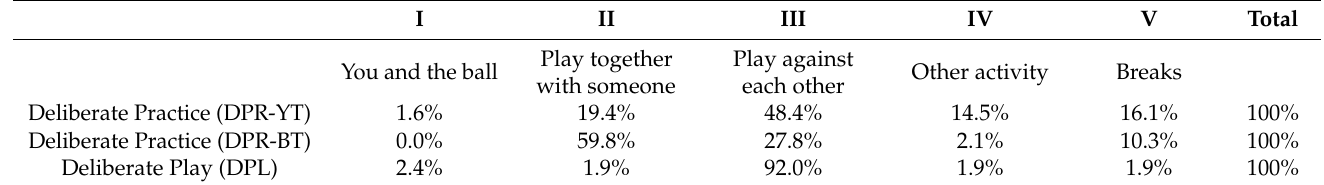
Table 3. Percentages of the time spent in different kinds of activities, divided between DPR-YT, DPR-BT, and DPL, registered on the average rates per every 5 min